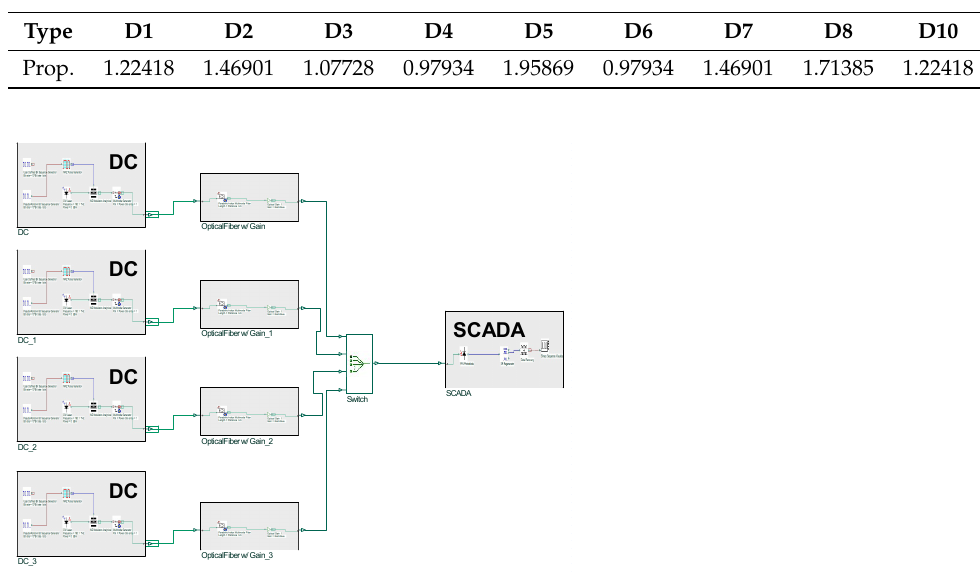
Figure 14. OptiSystems: schematic of multiple data concentrators connected to the SCADA side.